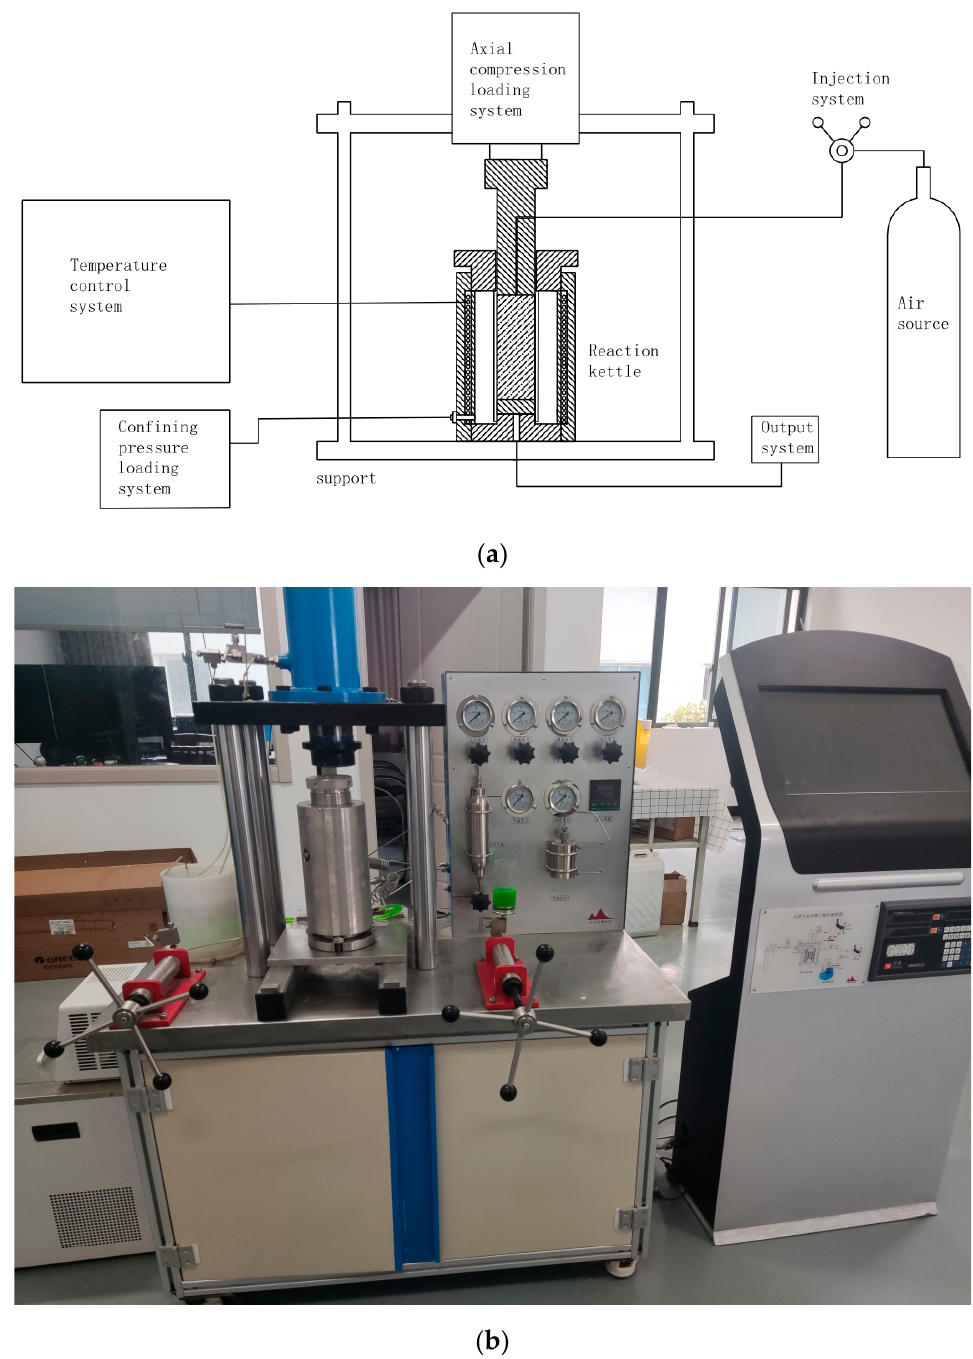
Figure 1. Hydrate triaxial-seepage test platform. ( a ) Schematic diagram of the hydrate triaxial-seepage test platform. ( b ) Physical picture of the hydrate triaxial-seepage test platform.